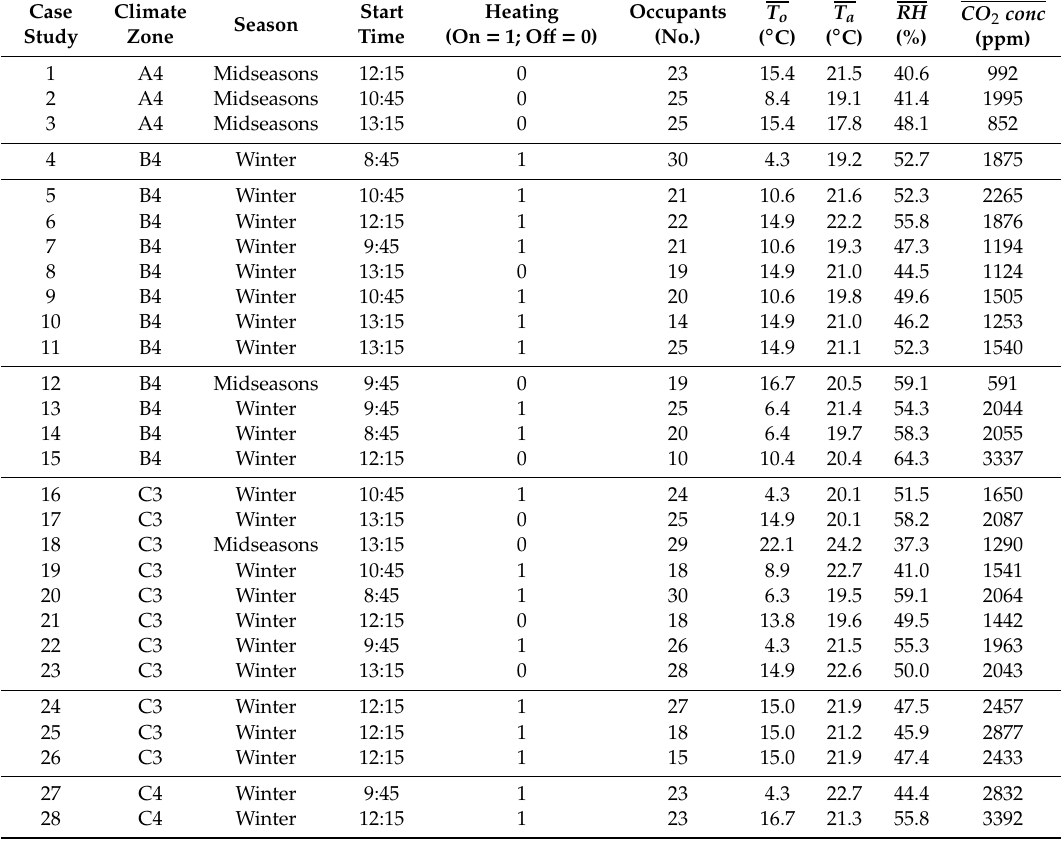
Table 2. Average values of indoor environment parameters with closed windows during the measurement period (45 min per case). Where: “Heating” is the heating system operation (On = 1; O ff = 0); “Occupants” is the number of occupants (No.); “ T is the mean indoor air temperature ( ◦ C); “ RH ” is the relative humidity ( ◦ C); “ CO 2 conc ” is the mean indoor CO 2 concentration